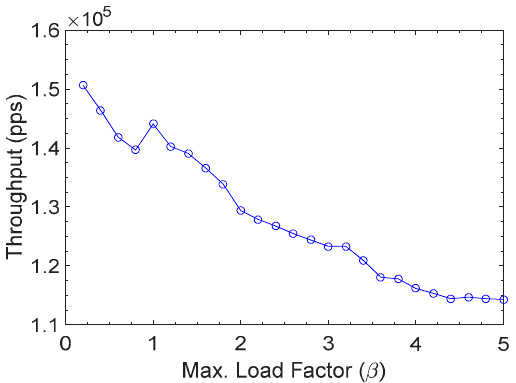
Figure 9. Throughput according to load factor.